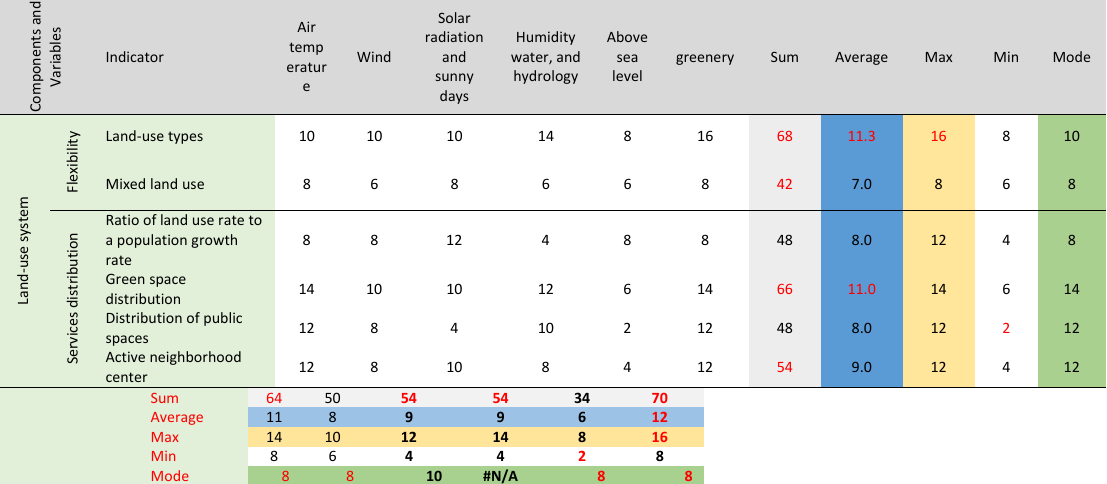
Table 5: Relation between Land‐use system and climate indicators